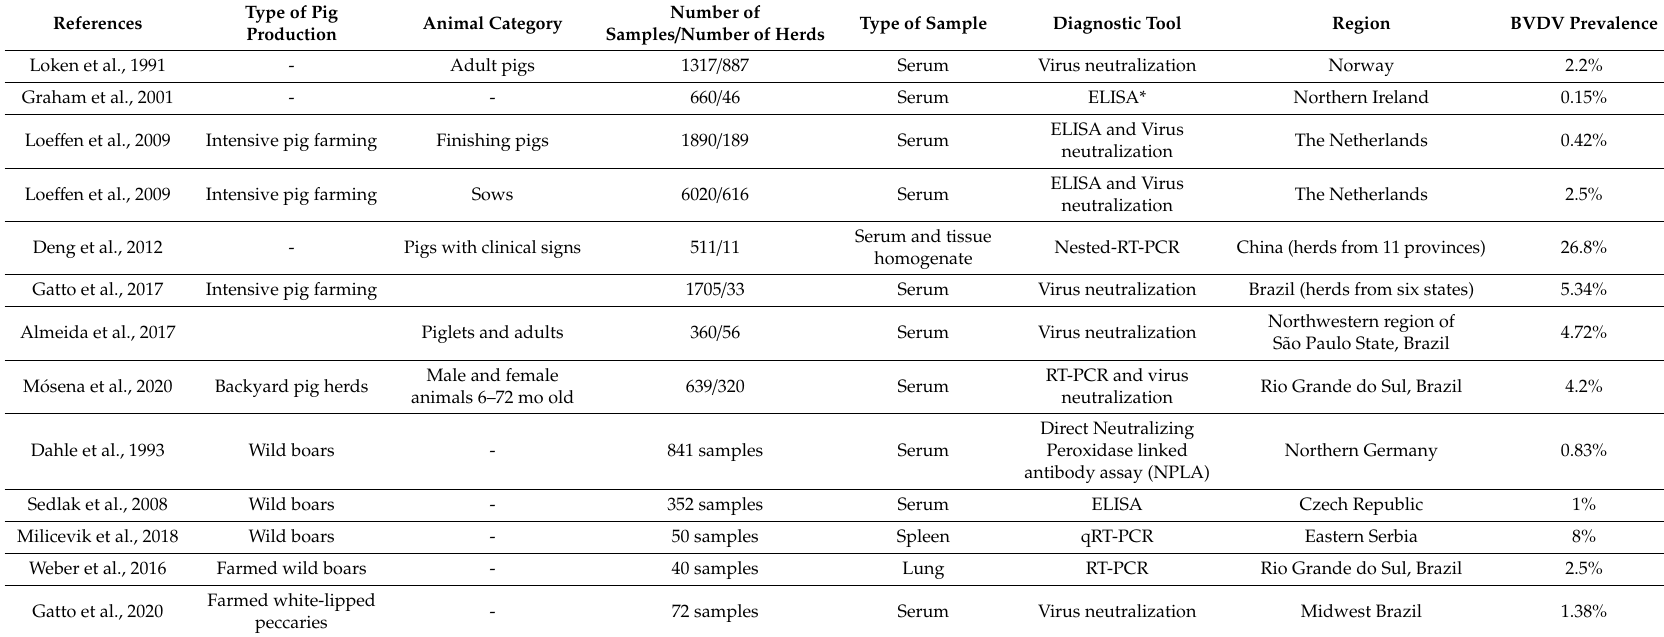
Table 1. Bovine viral diarrhea virus prevalence in intensive pig farming, backyard pig herds, and wild boars observed by several authors in di ff erent regions